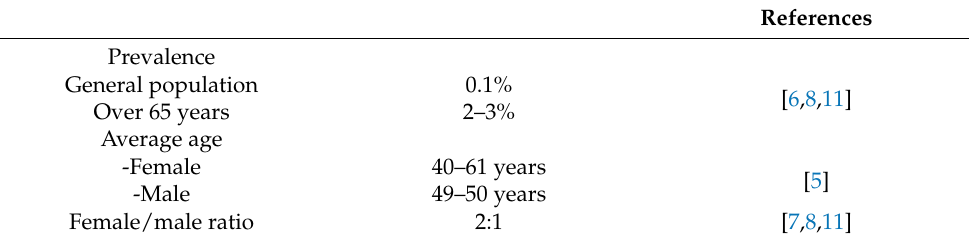
Table 1. Prevalence, age and gender in pernicious